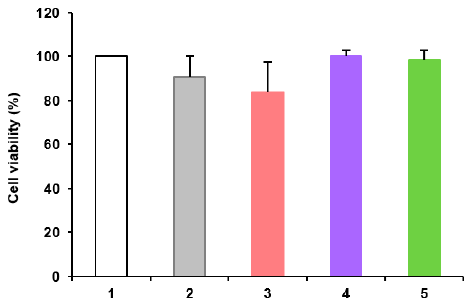
Figure 4. In vitro cytotoxicity in healthy immortalized human keratinocytes (HaCaT) investigated by